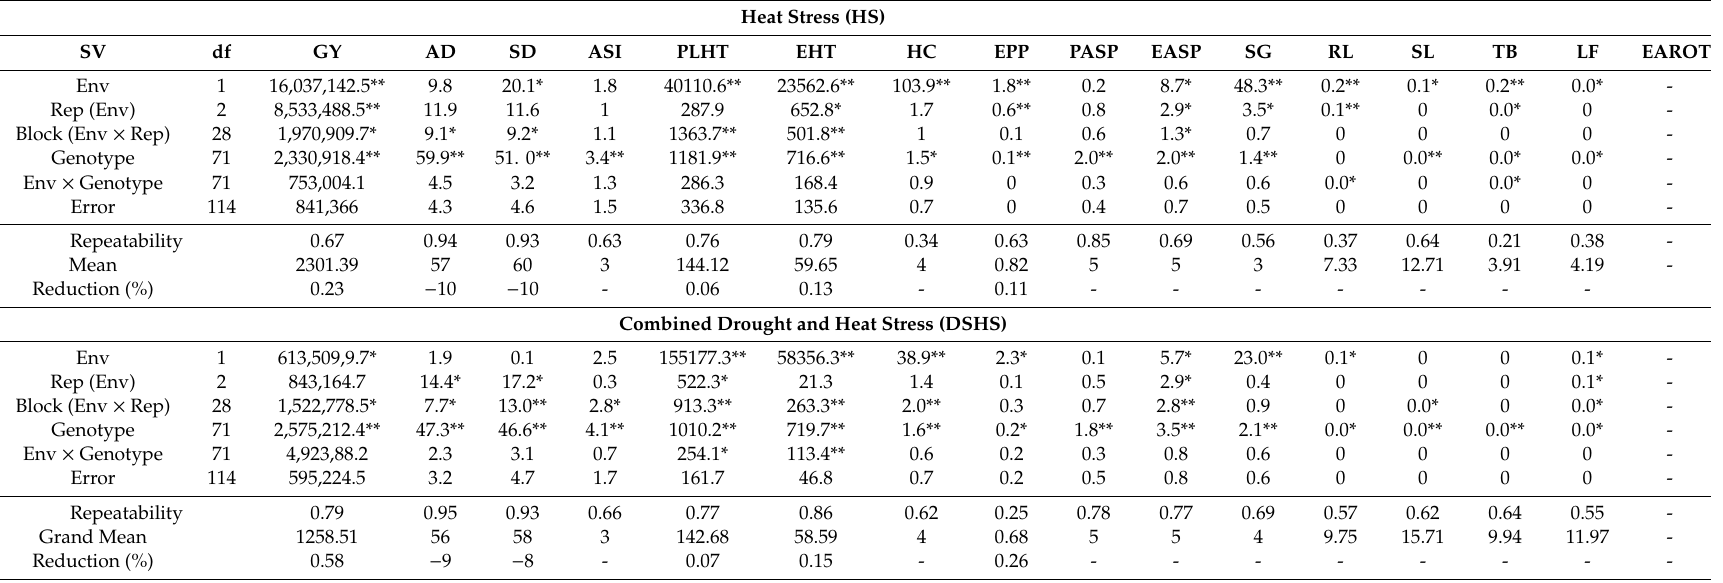
Table 2. Mean squares and repeatability of grain yield and other traits of 72 extra-early maturing maize accessions evaluated under heat stress and combined drought and heat stress conditions between 2017 and 2019 at Kadawa,